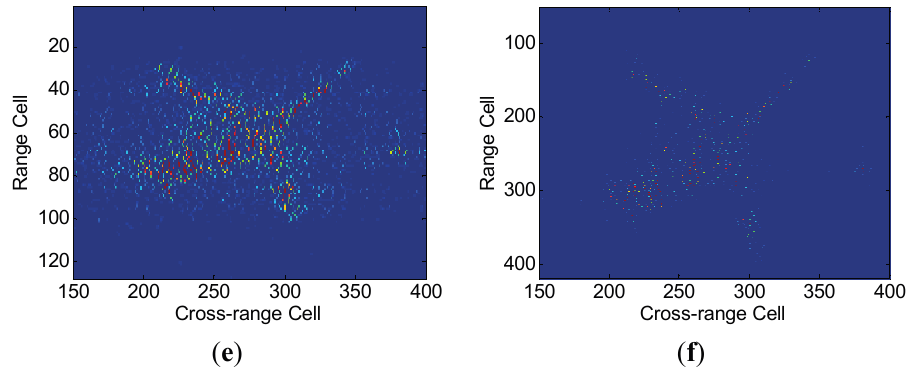
Figure 8. ( a ) ISAR image via IFFT-IFFT method; ( b ) ISAR image via existing IFFT-SR